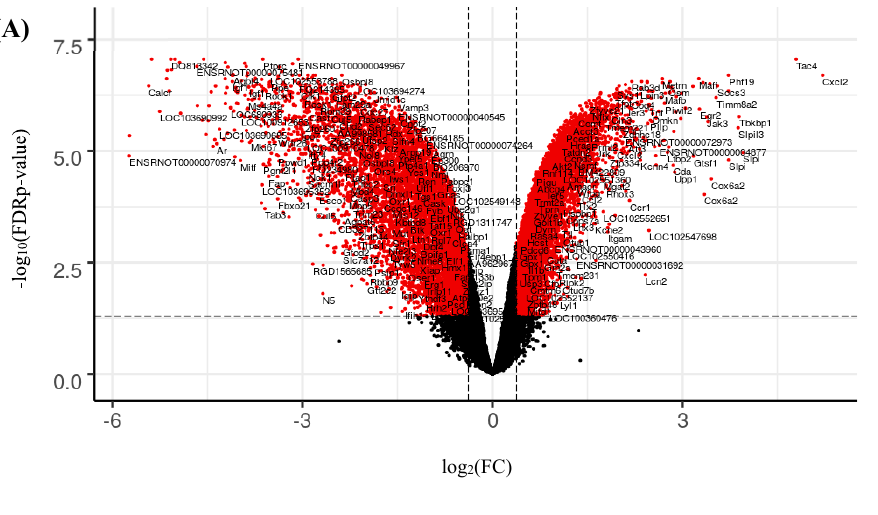
Table 2. Total number of differentially expressed genes (FDR corrected p -value <